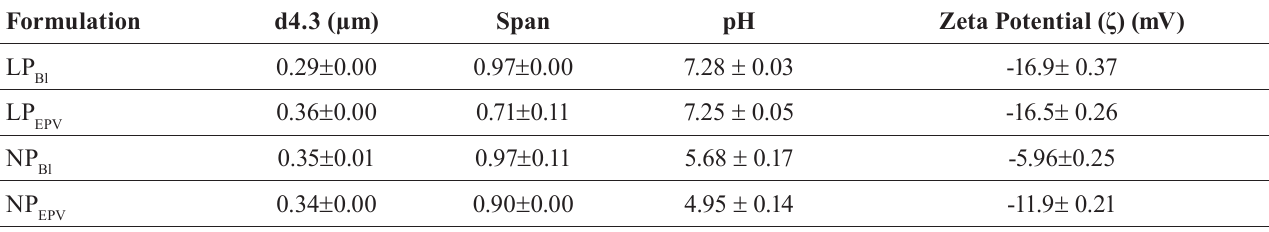
TABLE I - N anostructure characterization along 30 days of study